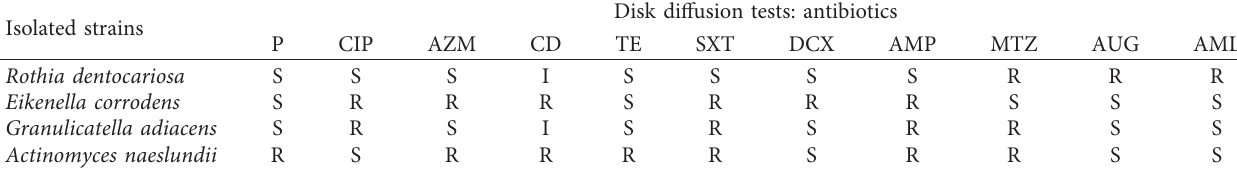
Table 1: Antimicrobial susceptibility of identified periodontal bacteria by disk diffusion tests. Isolated strains